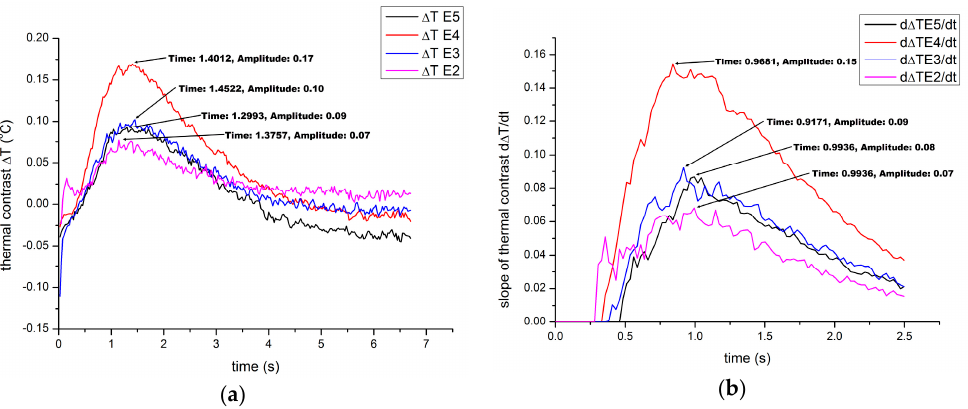
Figure 8. Temporal evolution of: ( a ) the thermal contrast curves; and ( b ) the correspondent slope of the thermal contrasts for the detected insertions on the trapezoid surface located to the depth of 1 mm (Series E).